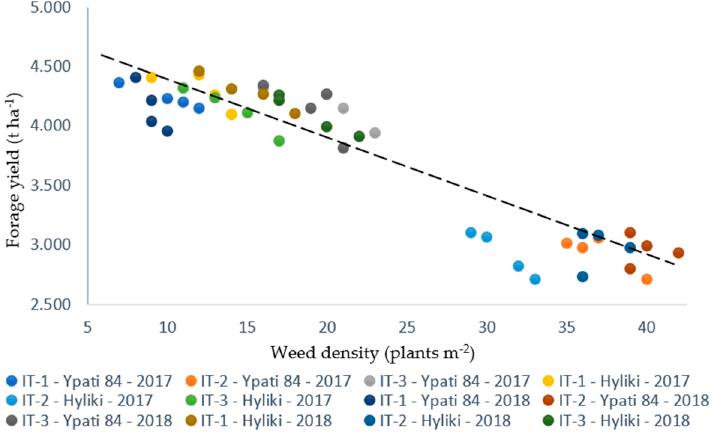
Figure 1. Linear regression between total weed density and alfalfa forage yield in the second harvest.